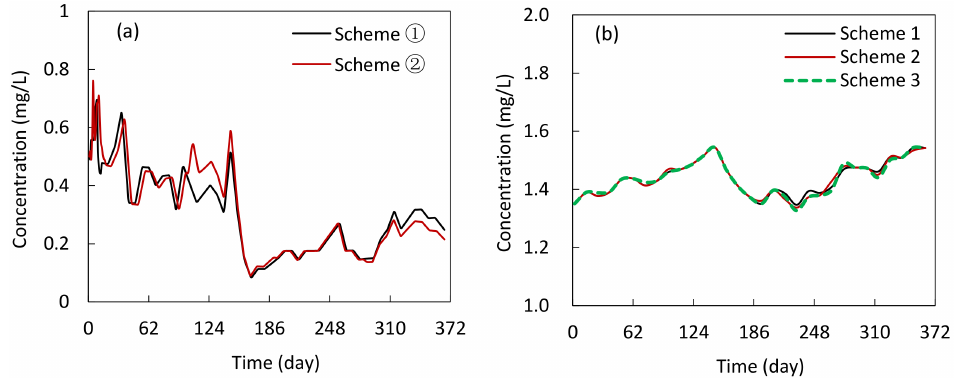
Figure 9. Results of different water diversion schemes: ( a ) concentration of TN at the outlet of the middle route; ( b ) concentration of TN at the dam of Chaohe under water diversion scheme 1 (cid:13)